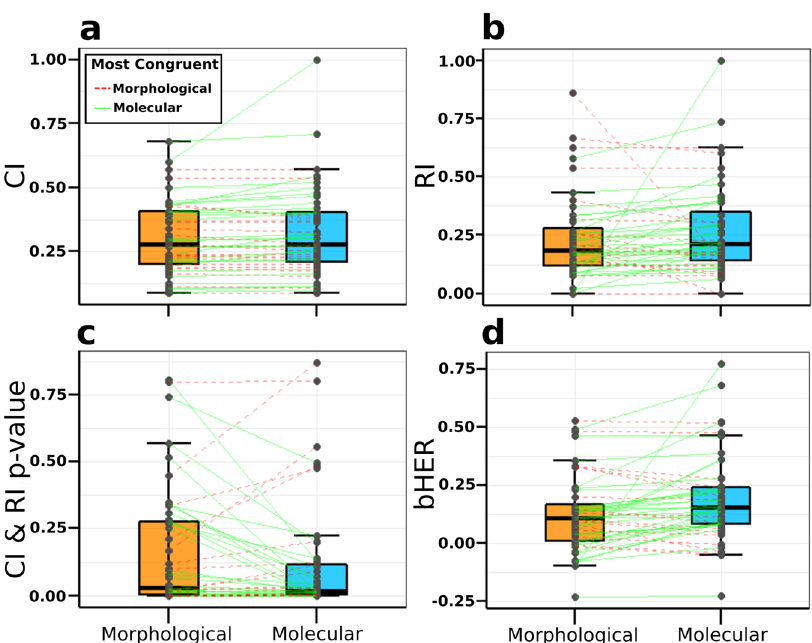
Fig. 3 Differences in biogeographic congruence between morphological and molecular trees. Boxplots of raw values and differences in values between morphological and molecular trees for the metrics of biogeographic congruence analysed in this study. a Consistency index (CI: W = 685, Z = 2.22, rc = 0.384, p value = 0.027). b Retention index (RI: W = 695, Z = 2.33, rc = 0.404, p value = 0.0199). c P values for the CI & RI random permutations (CI & RI p value: W = 373, Z = − 1.63, rc = − 0.279, p value = 0.104). d Biogeographic HER (bHER: W = 888, Z = 3.08, rc = 0.51, p value = 0.002). Boxes delimit the upper and lower quartiles of the data, while central bars are median values. Whiskers delimit plus or minus 1.5 times the interquartile range, from the fi rst and third quartiles. Coloured lines connected pairs of values from the same clade, where red dashed lines indicate the morphological tree is most biogeographically congruent and green solid lines indicate the molecular tree is most biogeographically congruent. N = 48 biologically independent pairs of morphological and molecular